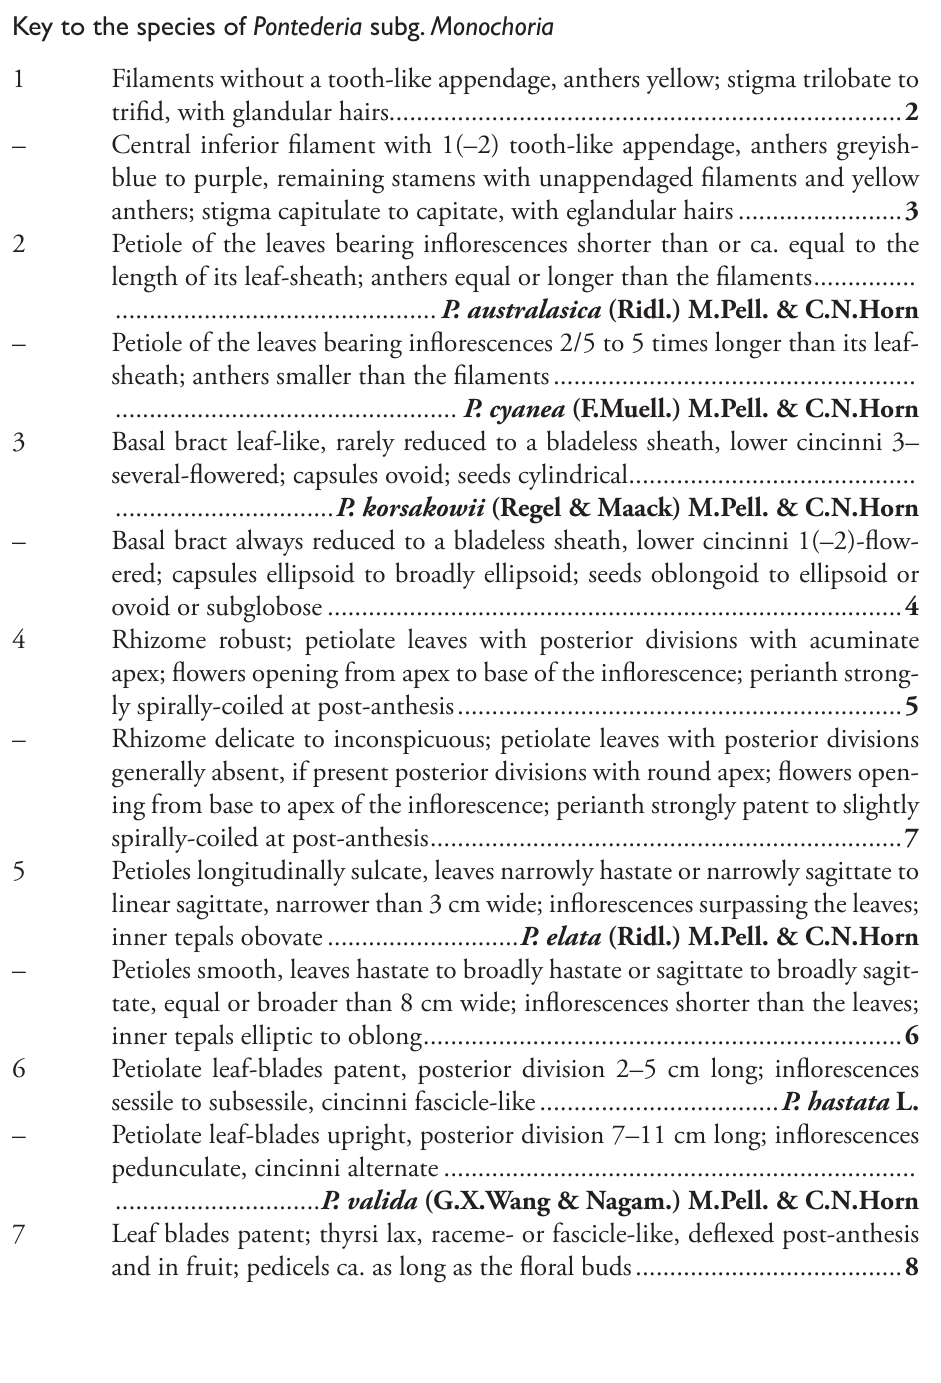
Leaf blades patent; thyrsi lax, raceme- or fascicle-like, deflexed